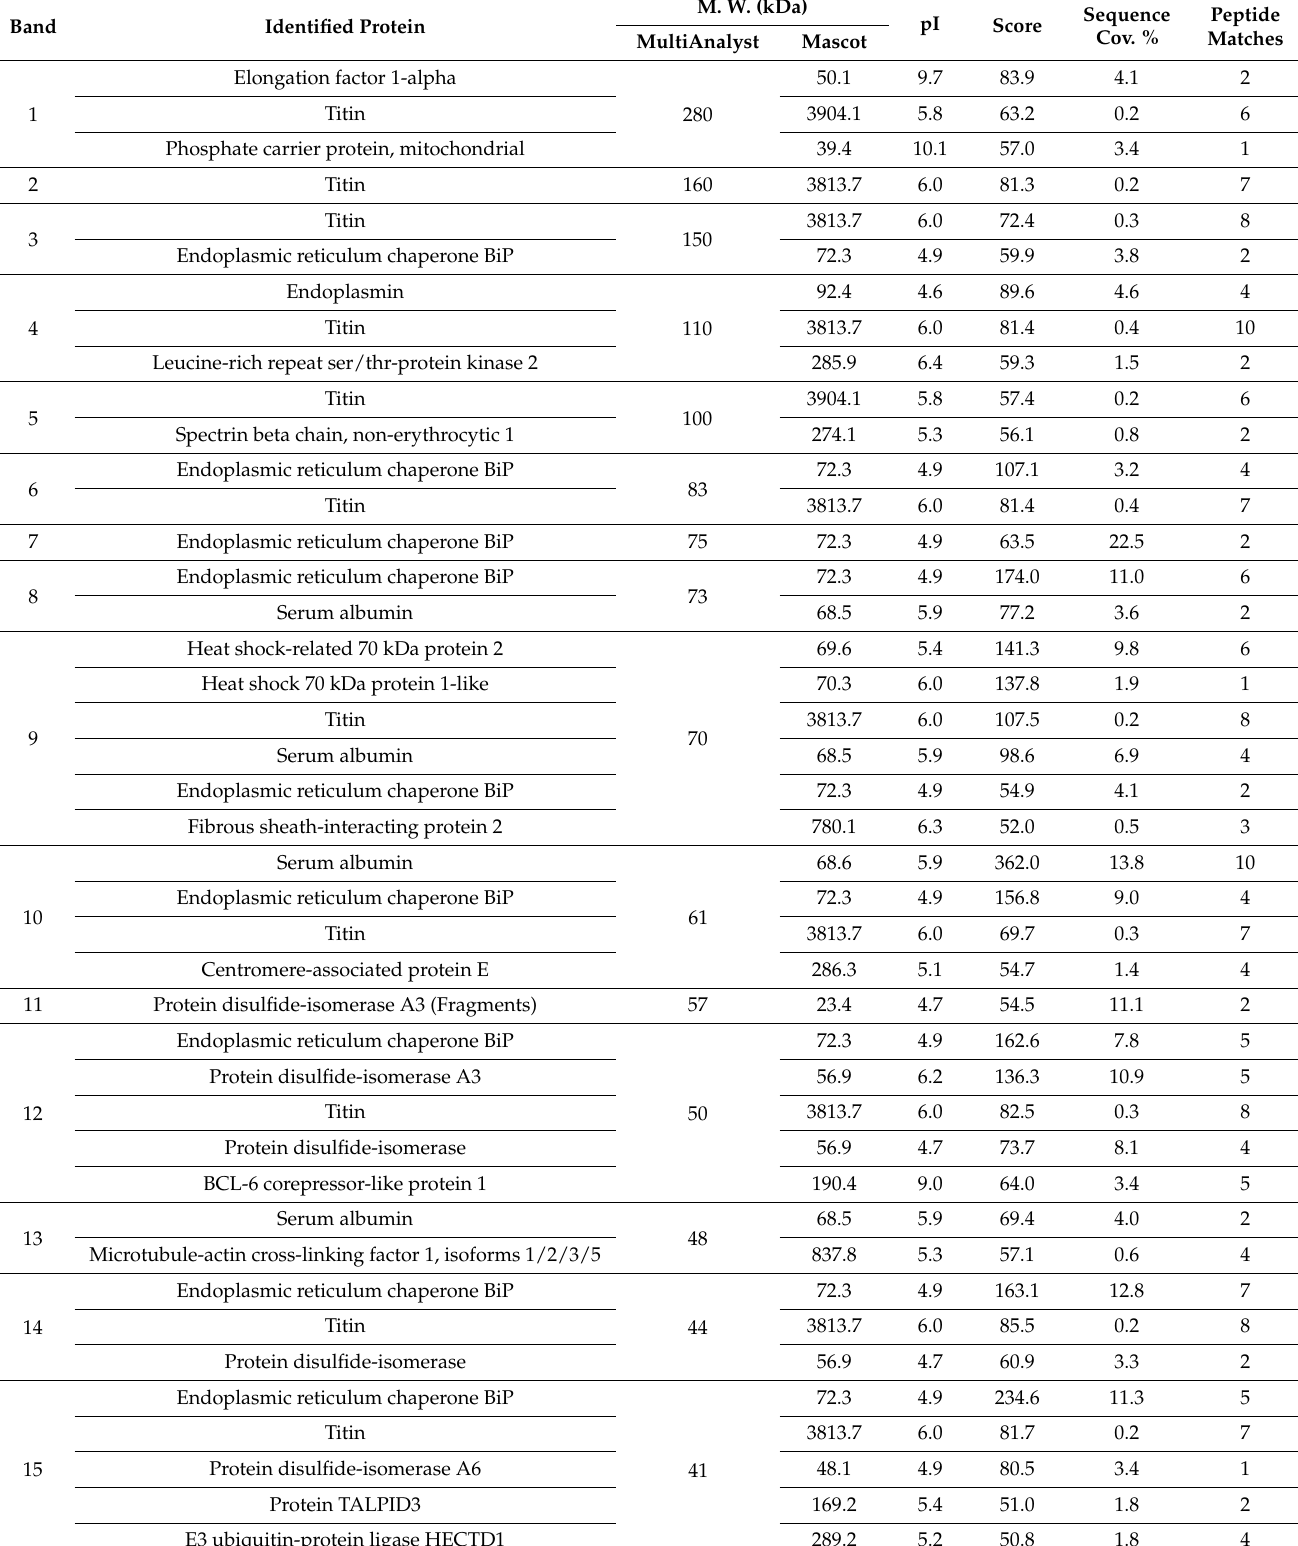
Table 1. Phosphoproteins identified by nanoLC–MS/MS